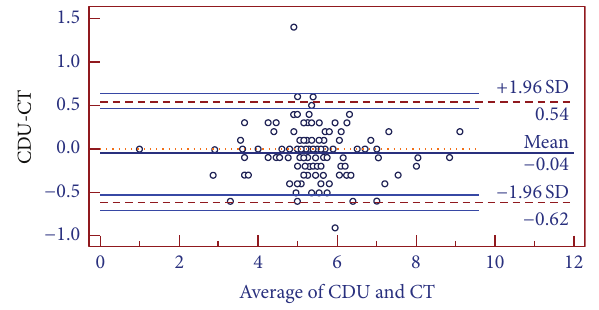
Figure 2: Bland and Altman plot for the whole cohort.